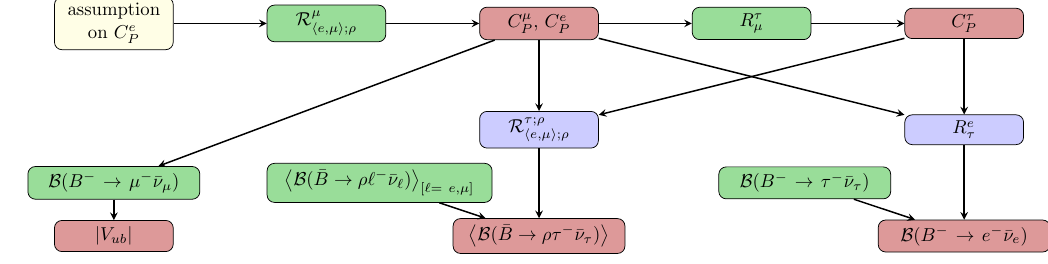
Figure 6: Flowchart illustrating our